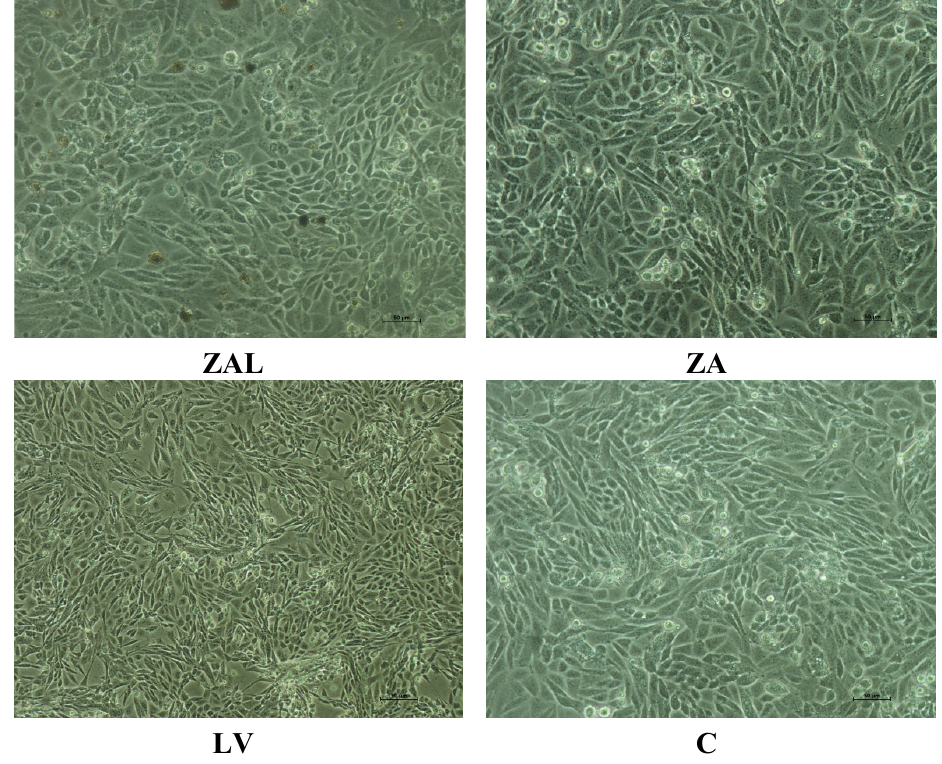
aluminum-levodopa nanoparticle, zinc aluminum nanoparticle, levodopa and untreated (control) respectively. No obvious changes noted between 24, 48 and 72 h post